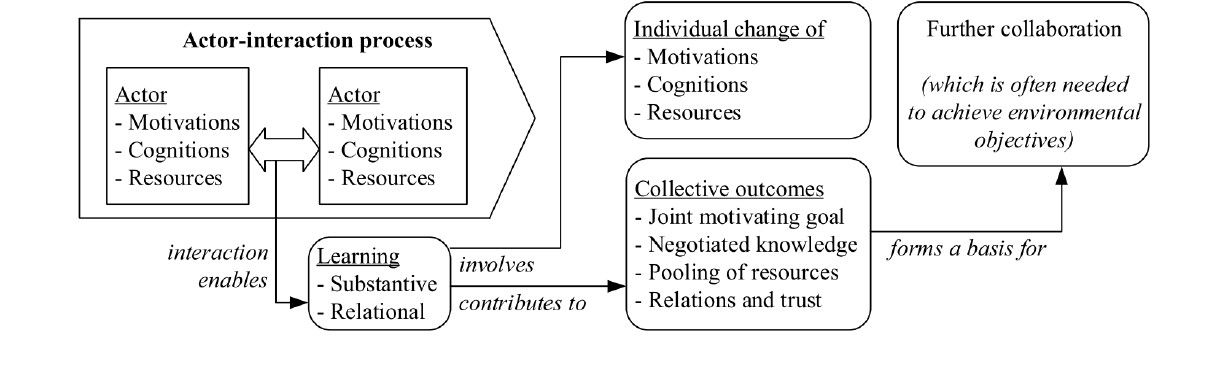
Fig. 1 . Conceptual model of the relation between learning and actor characteristics in actor-interaction